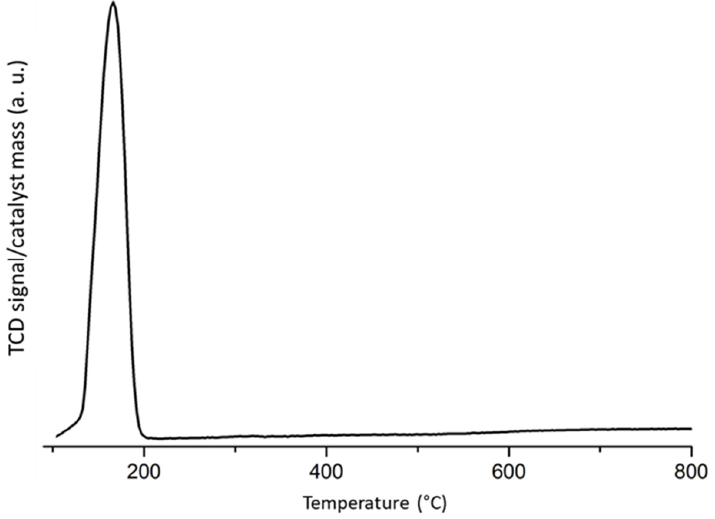
Figure 2. H 2 -TPR profile of 3Ru/CsUSY catalyst.